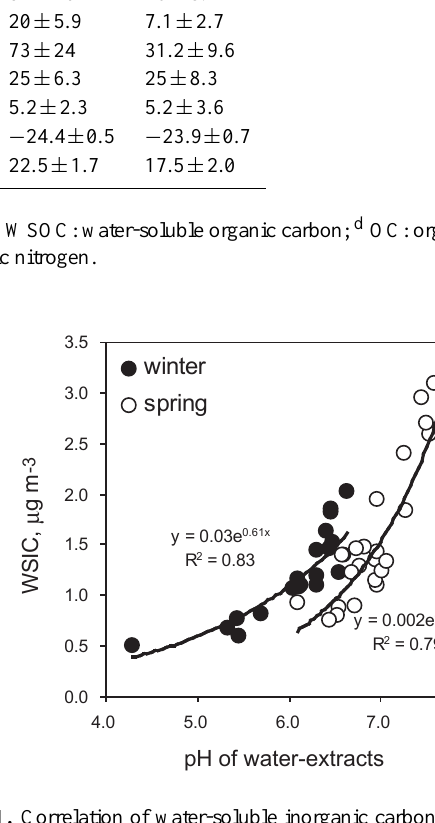
Fig. 2 Relative abundance of major species in the urban and suburban areas of Baoji City during winter and spring